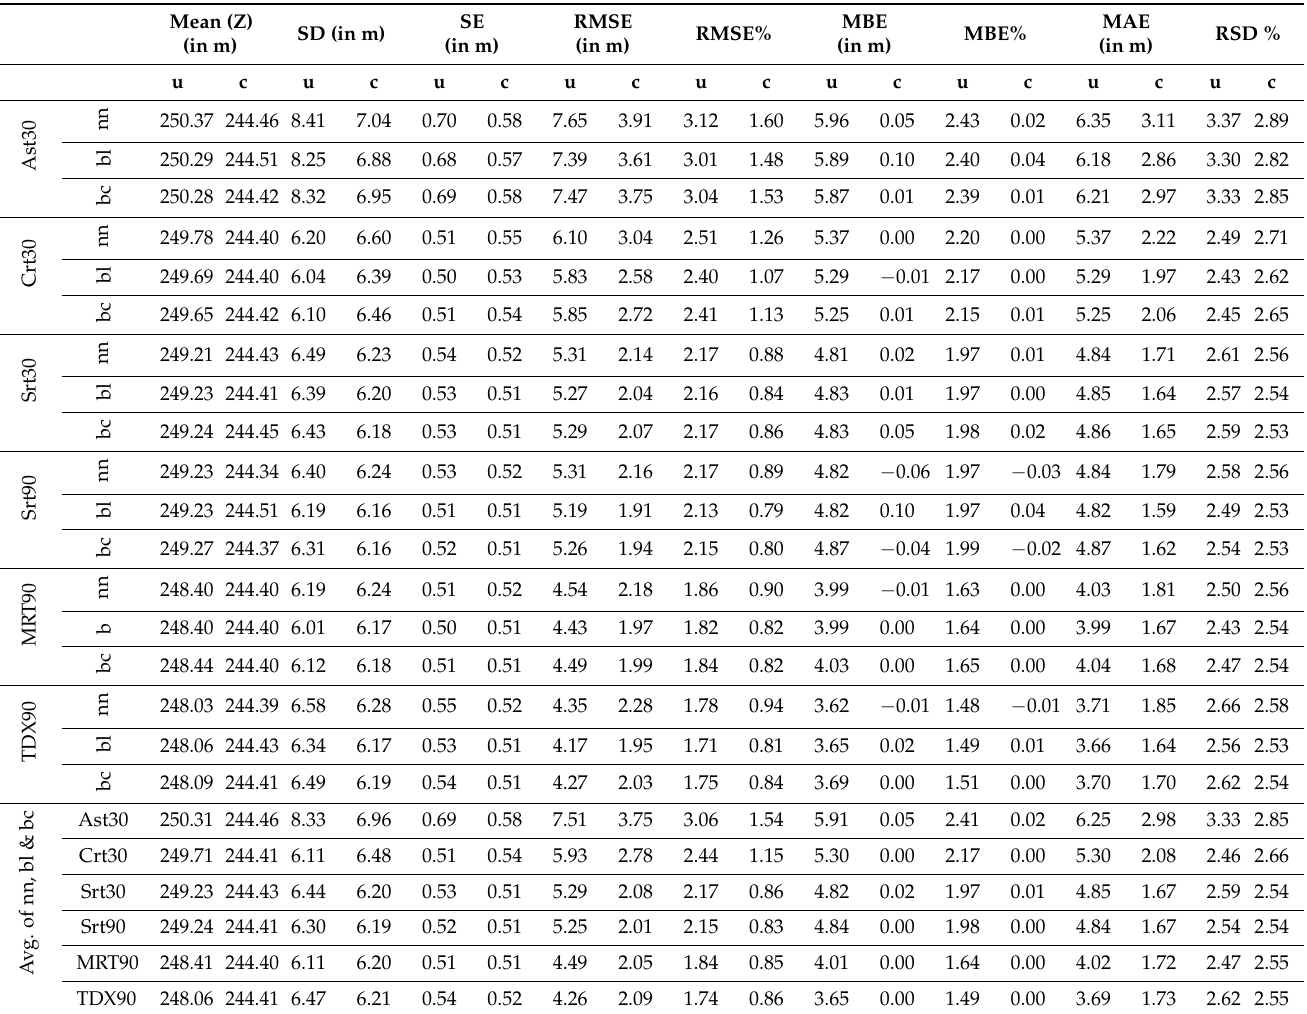
Table 4. The descriptive statistics and measures of differences between values obtained from the space-based DEMs (ASTER, CARTOSAT, SRTM, MERIT, and TanDEM-X) and one of the ground- based devices (DGPS) based on their positional estimates of “elevation (Z)” at the GCPs locations. The “u” refers to the use of “uncorrected DEM elevation data”. The “c” refers to the use of “corrected DEM elevation data” based on the DGPS data and the model (Table 5) applied for correction of DEMs in this study. Further, the DEM resampling over the GCPs was carried out using the three interpolation methods (nearest neighbour (nn), bilinear (bl), and bicubic (bc)) for